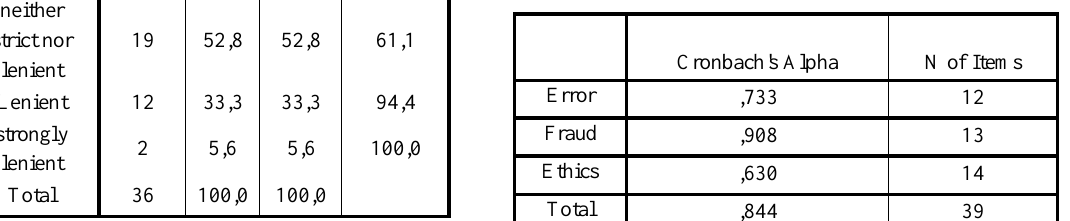
Table 14: Reliability Statistics